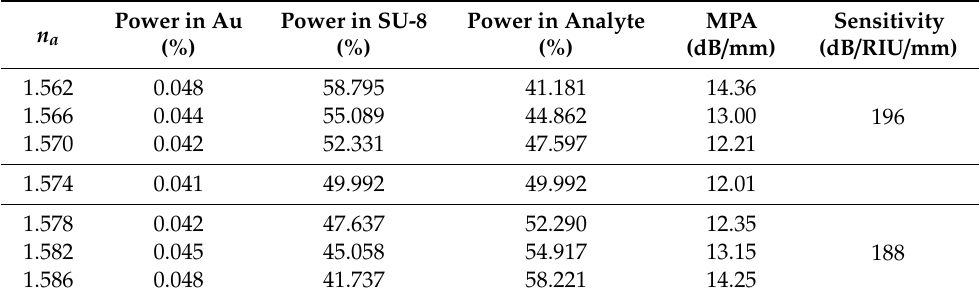
Table 1. Mode power distribution in SU-8, Au-stripe, and analyte.